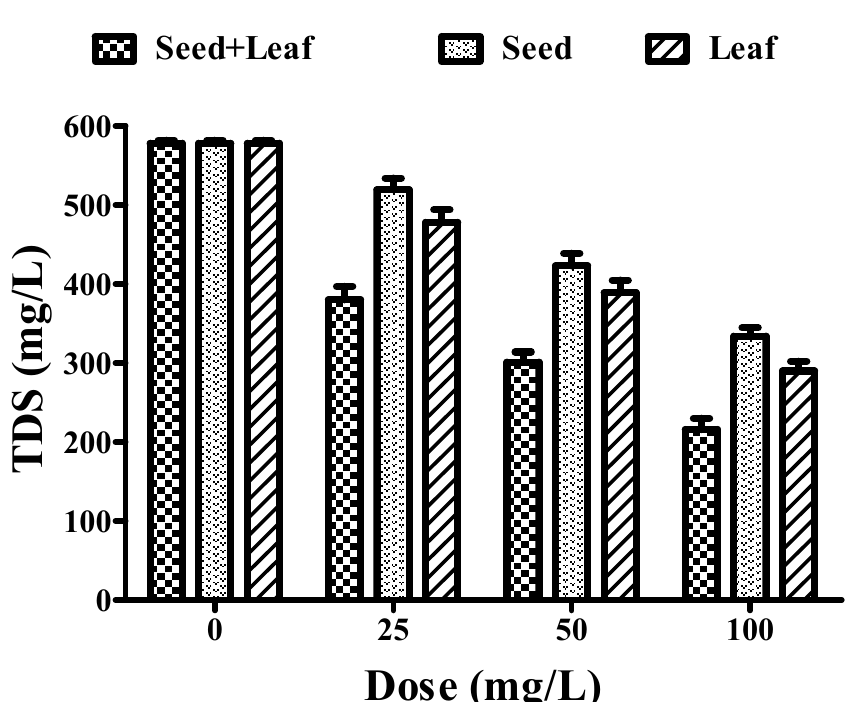
Figure 2. Comparative experimental analysis of combined (seed and leaf) and individual extracts of the Moringa oleifera plant on TDS parameters of groundwater at different doses (25–100 mg/L). All the experiments were done three times in triplicates and presented as mean ± SEM.